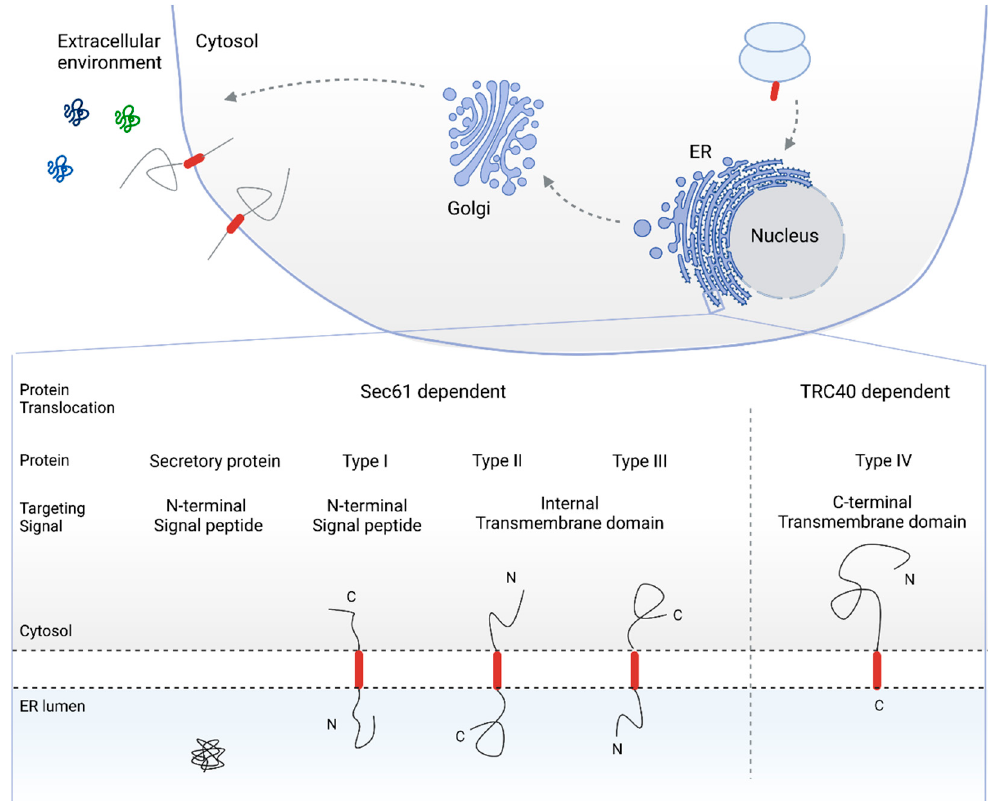
Figure 1. Overview of the secretory pathway for protein biogenesis and topology-based classification of secretory and single pass membrane proteins. Cleavable N-terminal SPs target secretory and type I membrane proteins to the ER membrane, resulting in an N-terminally translocated topology. In the case of type II and type III membrane proteins, the TMD functions as a targeting sequence. Depending on the overall hydrophobicity and charge of the topological sequences adjacent to the TMD, the C- or N-terminal end of the protein is translocated into the ER lumen (type II and type III single pass membrane protein, respectively). Type IV, or TA proteins, are targeted to the ER membrane via the C-terminal TMD. As a result, TA proteins are post-translationally translocated via the TRC-40 pathway. SP: signal peptide, ER: endoplasmic reticulum, TMD: transmembrane domain, TA: tail-anchored, TRC-40: transmembrane recognition complex subunit of 40 kDa.